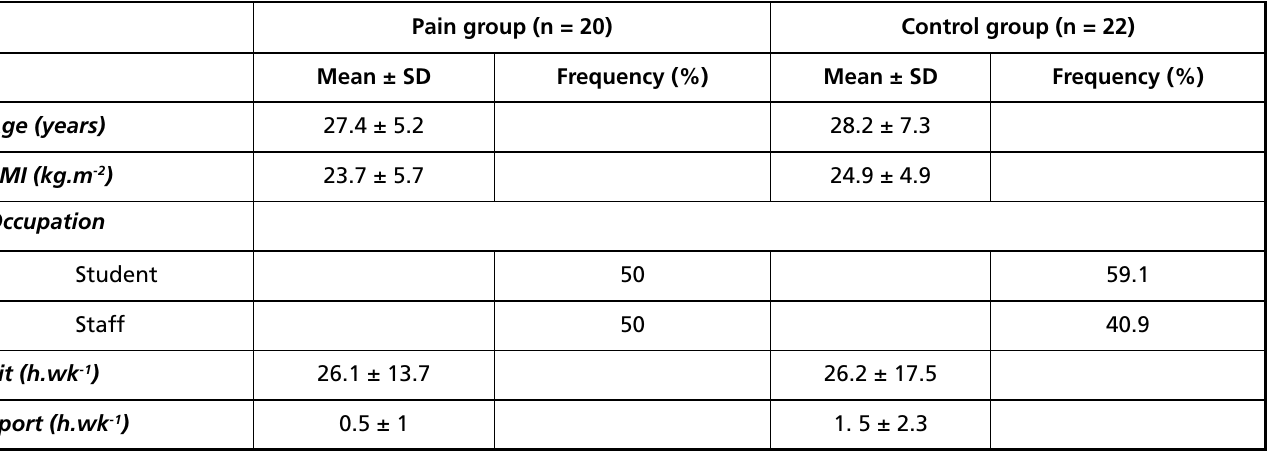
table 1: socio-demographic characteristics (n = 42)